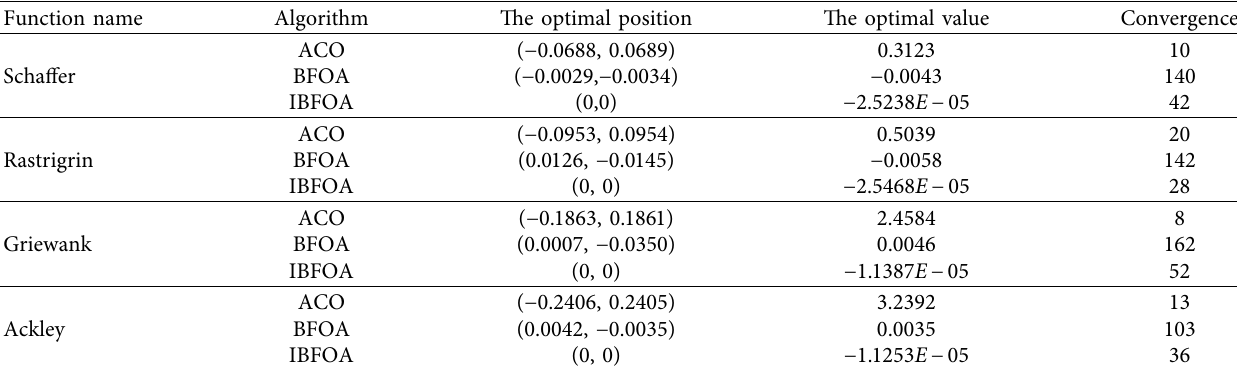
Figure 5: Simulation results of the benchmark tests: (a) Schaffer; (b) Rastrigrin; (c) Griewank; (d) Ackley. Table 4: Running results of test